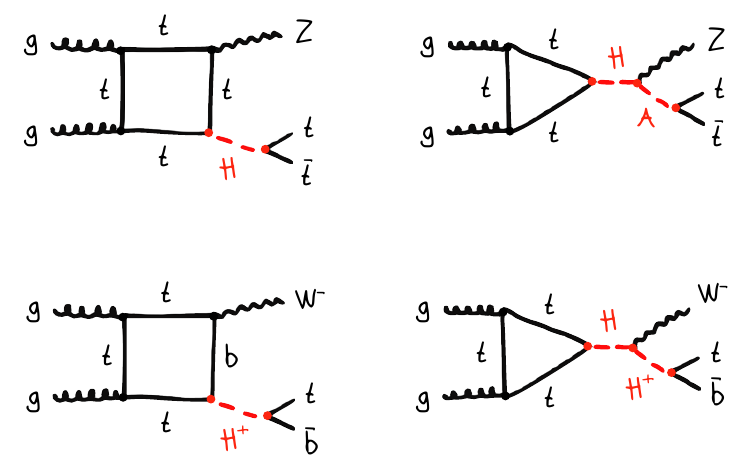
Figure 2 . Examples of Feynman diagrams that involve the exchange of non-SM Higgses and contribute to the process gg ! t (cid:22) tZ (upper row) and gg ! t (cid:22) bW (cid:0) (lower row). See text for further